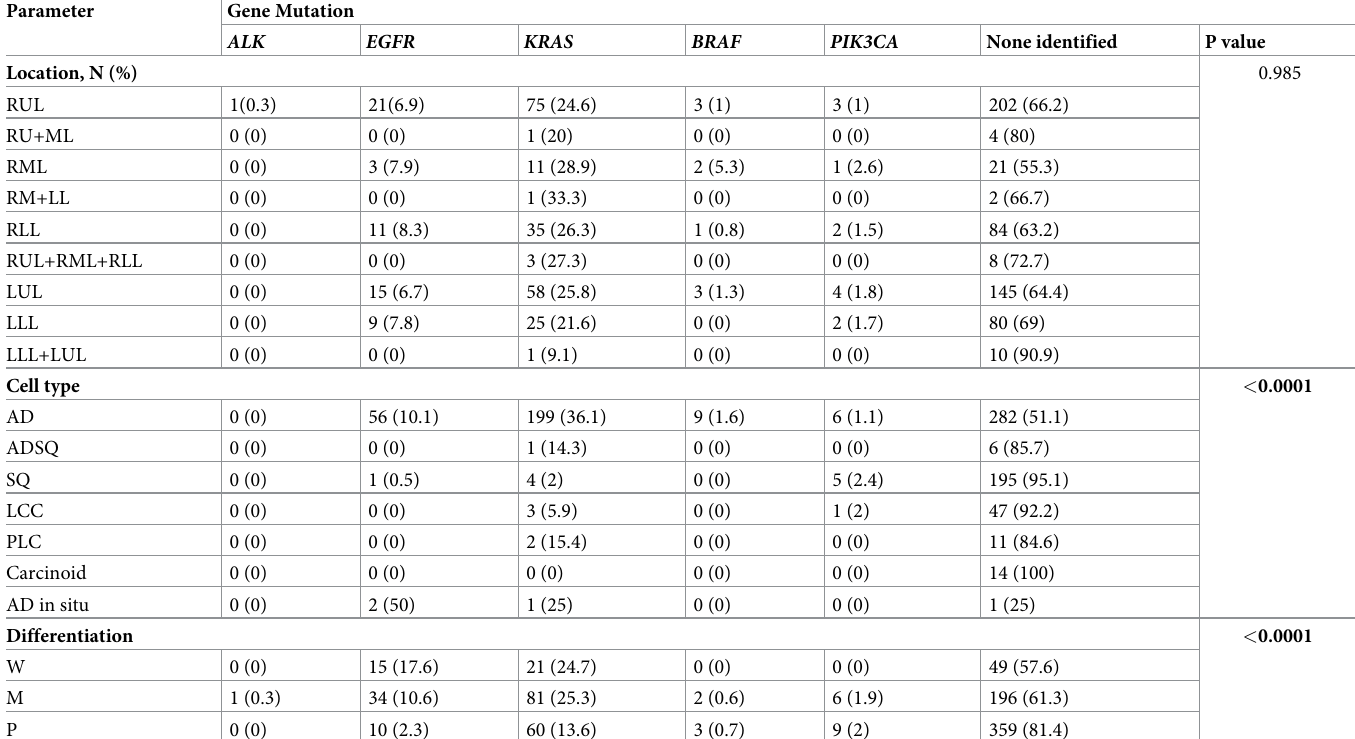
Table 5. Pathological characteristics of patients with NSCLC (N = 851) and their relationship with the most common gene mutations.